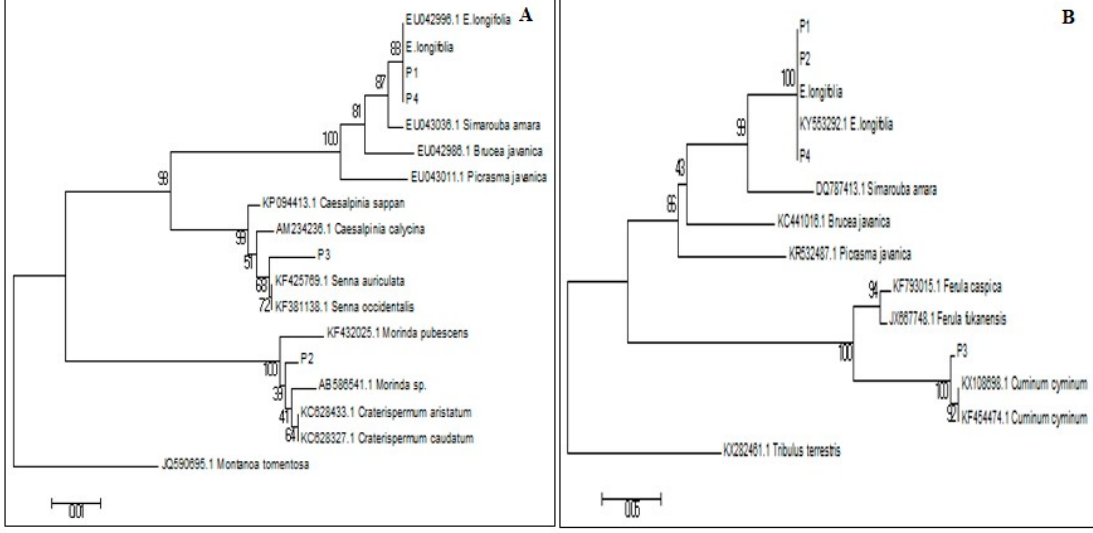
Figure 4. Phylogenetic tree of E. longifolia and commercial herbal products (P1, P2, P3, P4) with other plant species constructed from rbcL ( A ) and ITS2 ( B ) sequences using Neighbour Joining (NJ) Analysis with 1000 bootstrap replicates.